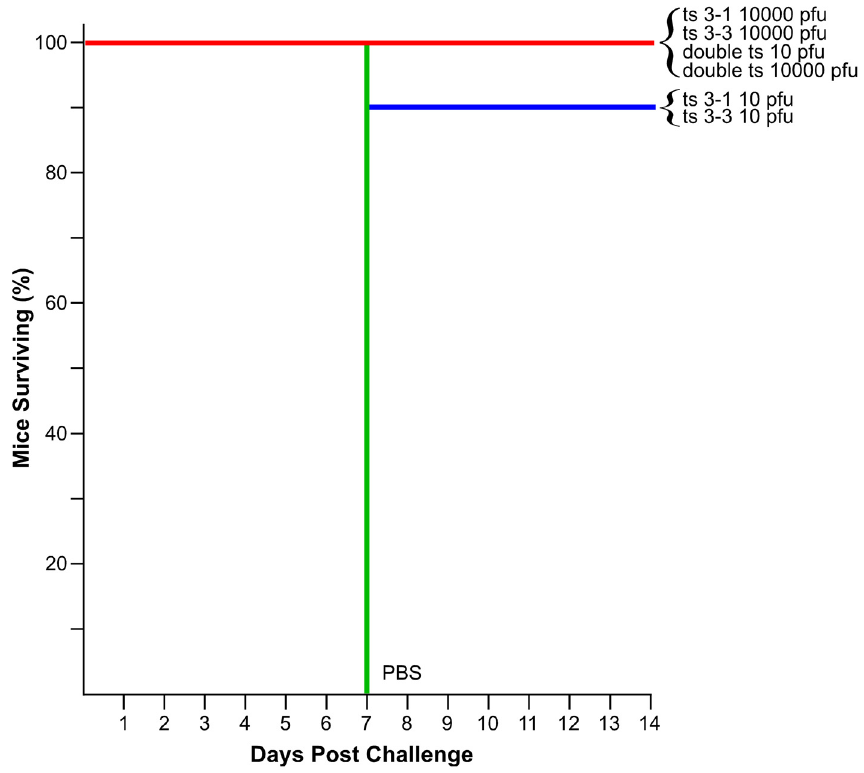
Figure 7. Kaplan-Meier analysis of mouse survival after challenge. Groups of 10 mice were innoculated with the VEEV ts strains and doses indicated along the right hand side of the graph, or with PBS. 28 days post innoculation, mice were challenged with 10 4 pfu of wild-type VEEV strain Trinidad donkey and monitored for an additional 28 days. Mice were euthanized when moribund. All mice surviving to day 14 survived to day 28, when the study was